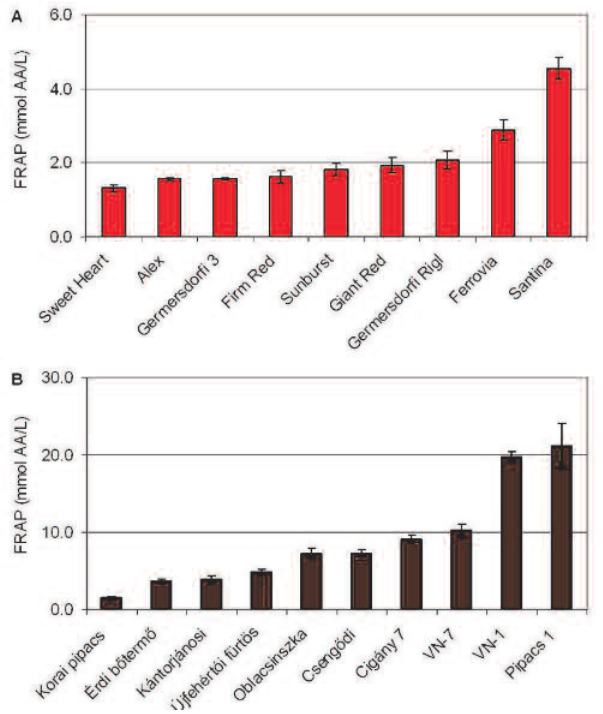
Figure1. Total antioxidant capacity of sweet (A) and sour (B) cherry cultivars.